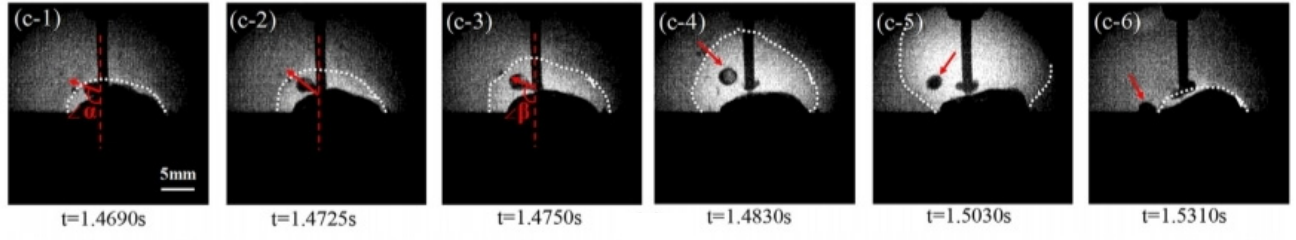
Figure 13. Droplet transfer into a spatter at different time intervals [25]. Reprinted with permission from Ref. [25]. 2022, Elsevier.